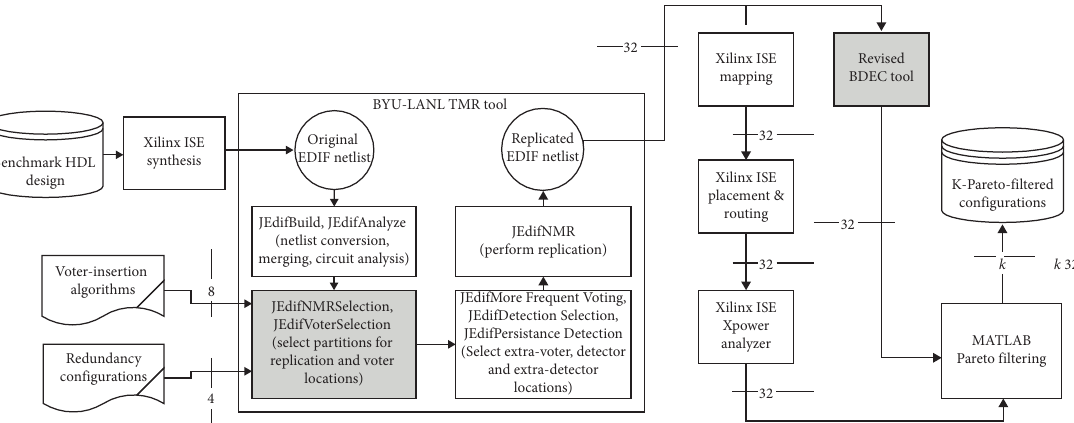
Figure 8: DRM deisgn-time tool